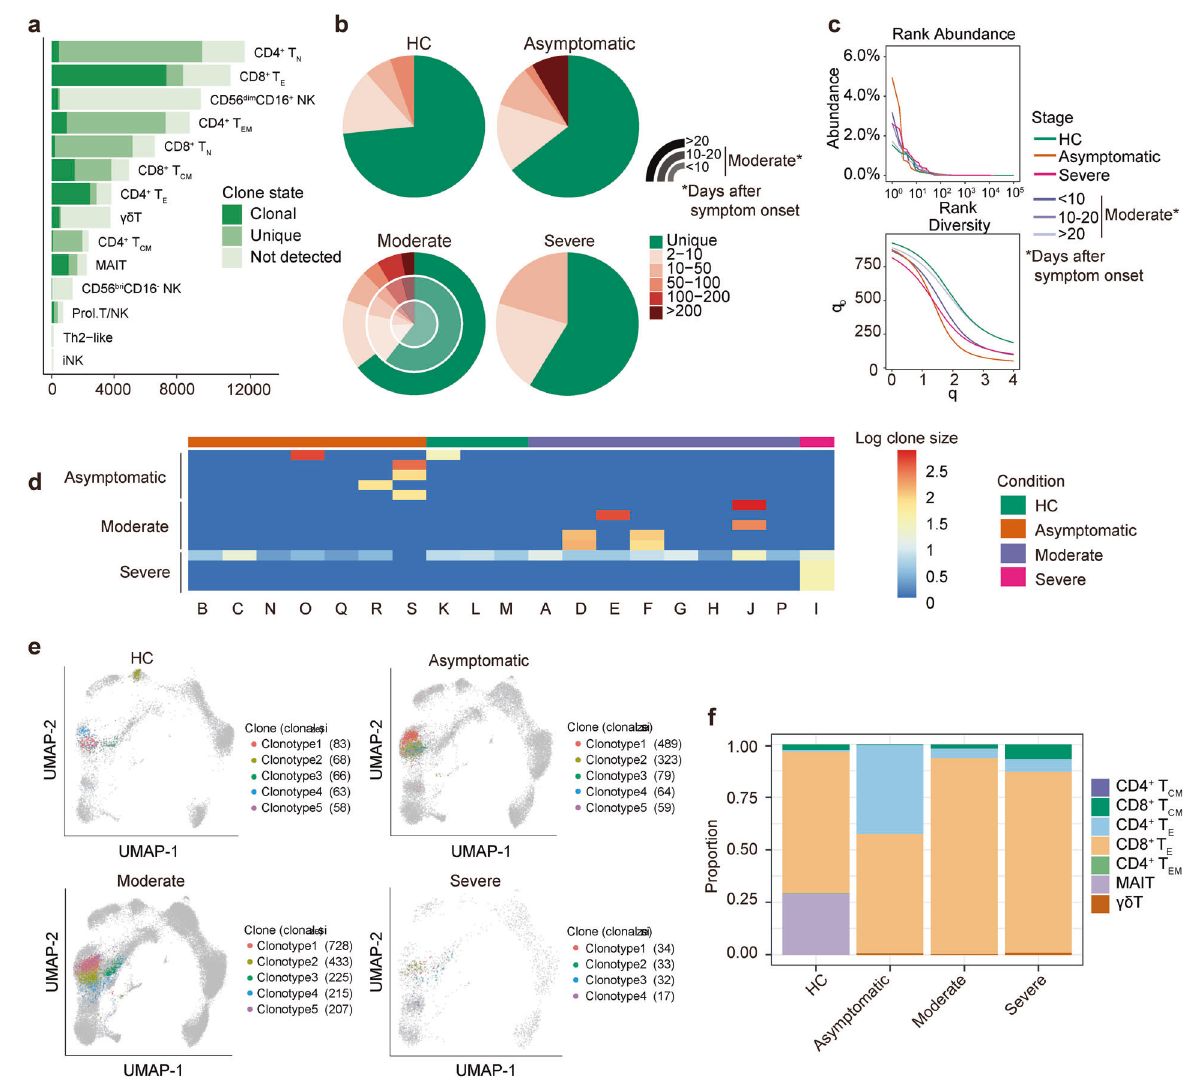
Fig. 5 Expanded TCR clones and selective usage of V(D)J genes. a Bar plots showing the cells from T and NK cell subtypes whether they have TCR and their TCR clonal status. b The percentage of the clonal status of T cells with TCR. The clonal status was de fi ned by clone size in four disease conditions. c TCR abundance and diversity on CD4 + and CD8 + T cells across disease conditions and stages generated by alakazam package. The 95% con fi dence interval is estimated via bootstrapping ( B = 200). d Heatmap of log 10 -transformed clone sizes of top three abundant clonotypes within each condition (not including healthy controls [HC]) across patients. e UMAP of T cells derived from PBMCs for different conditions. Clusters are denoted by colors labeled with TCR clones with the top 5 largest clone sizes in each condition. f Proportions of cell types that produce the top fi ve abundant clonotypes within each condition. Color denotes cell Clonal expansion in T cells and usage of V(D)J genes COVID-19 patients